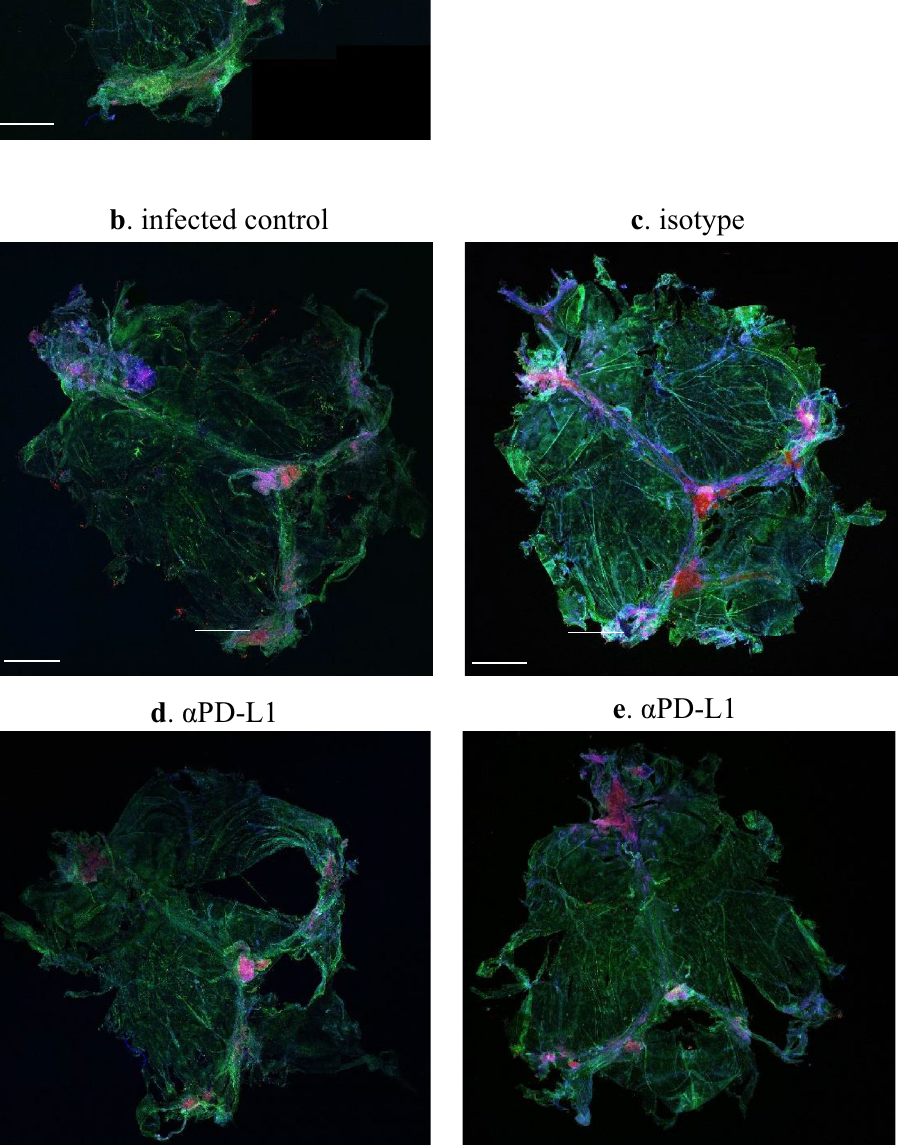
Figure 4. Leukocytes diminished in the meninges 6 weeks after αPD-L1 treatment. Representative images of CD3e (red), CD14 (green) labelling in whole-mount meninges (scale bar, 2000 mm) for uninfected control ( a ), infected control ( b ), isotype ( c ), αPD-L1 ( d & e ). DAPI was used to identify nuclei